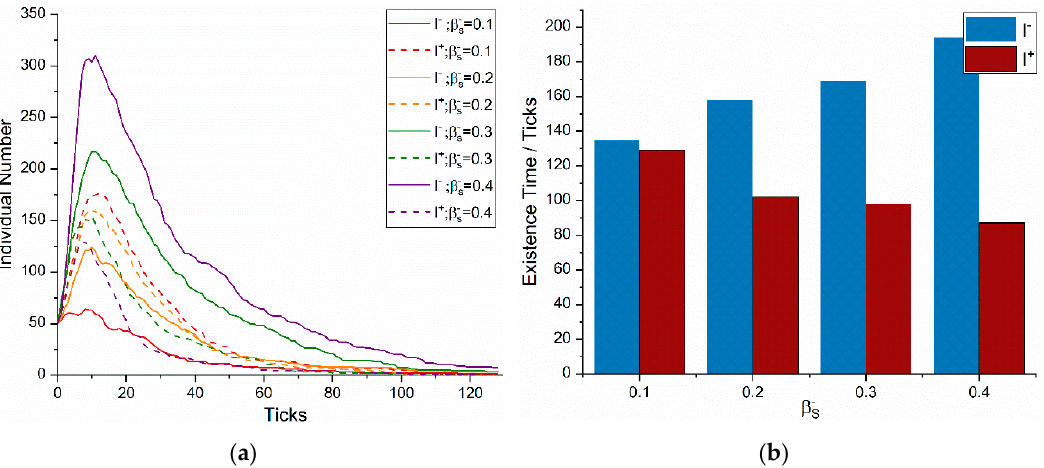
Figure 5. OWOM communication effect when the negative OWOM acceptance index is different. ( a ) The individual number of brand advocators and protesters; ( b ) the existence time of positive and negative OWOM.